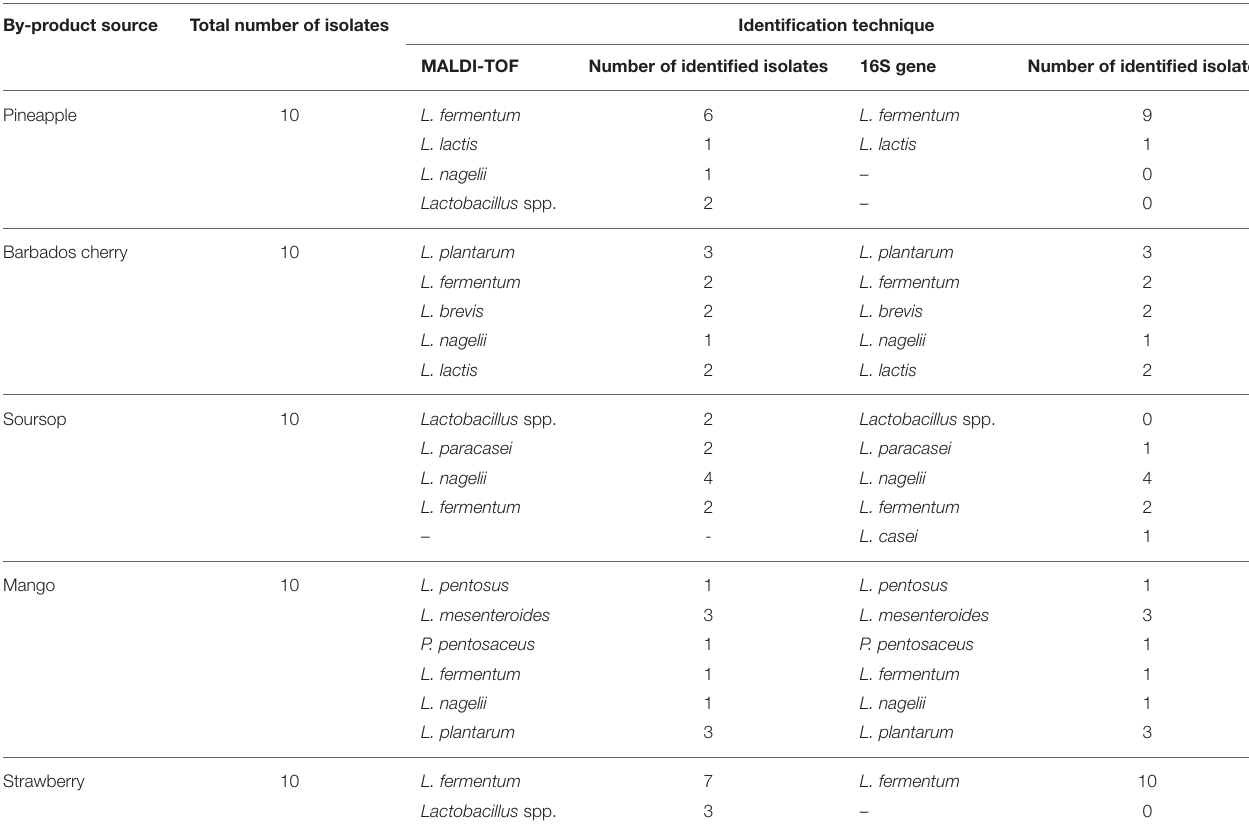
TABLE 1 | Identification of lactic acid bacteria isolates from different fruit pulp processing byproducts (total number of isolates from each source, technique applied for identification and number of isolates identified by each applied identification technique). By-product source Total number of isolates Identification technique MALDI-TOF Number of identified isolates Pineapple